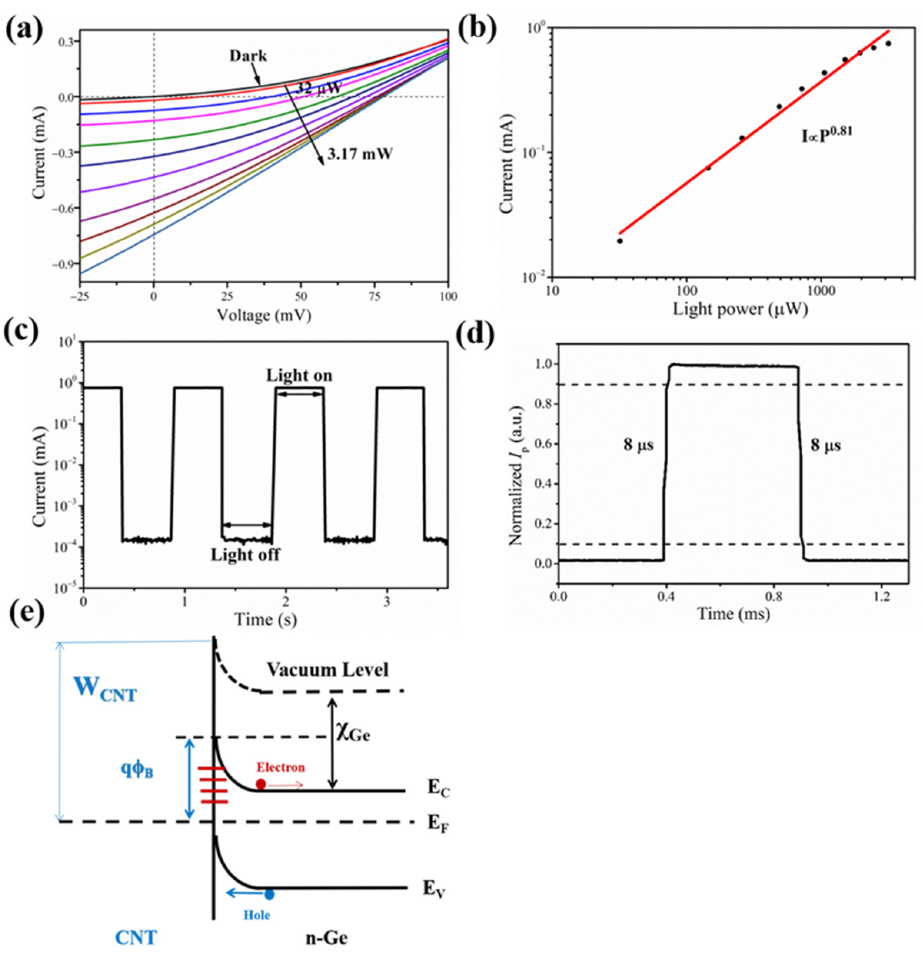
Figure 2. ( a ) The incident photovoltaic characteristics of the AuNPs-modified SWCNT/Ge photode- tector with a gradually increasing light power from 32 μ W to 2.37 mW. ( b ) The fitting curve between the photogenerated current and the optical power under a 1550 nm light illumination. ( c ) The turned on and off photo responses of the AuNPs-modified SWCNT/Ge photodetector without an external power supply under a 1550 nm illumination. ( d ) The normalized cycle measurement at 1 kHz for the response time ( τ r ) and recovery time ( τ f ). ( e ) The energy band schematic of the AuNPs-modified SWCNT/Ge